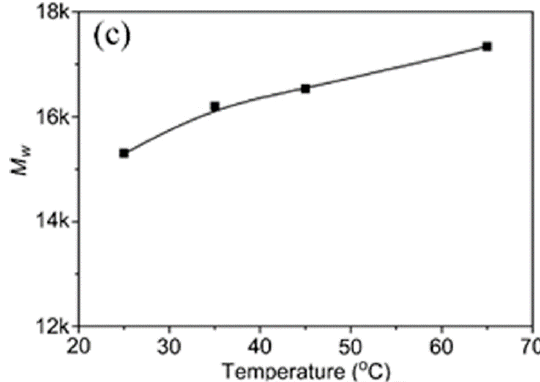
Figure 20. Molecular weight of produced phenyl silsesquioxanes with ( a ) initial concentration of PTMS, ( b ) water concentration, and ( c ) temperature of the reaction medium. Reprinted with permission from [29]. Copyright Elsevier, 2016.